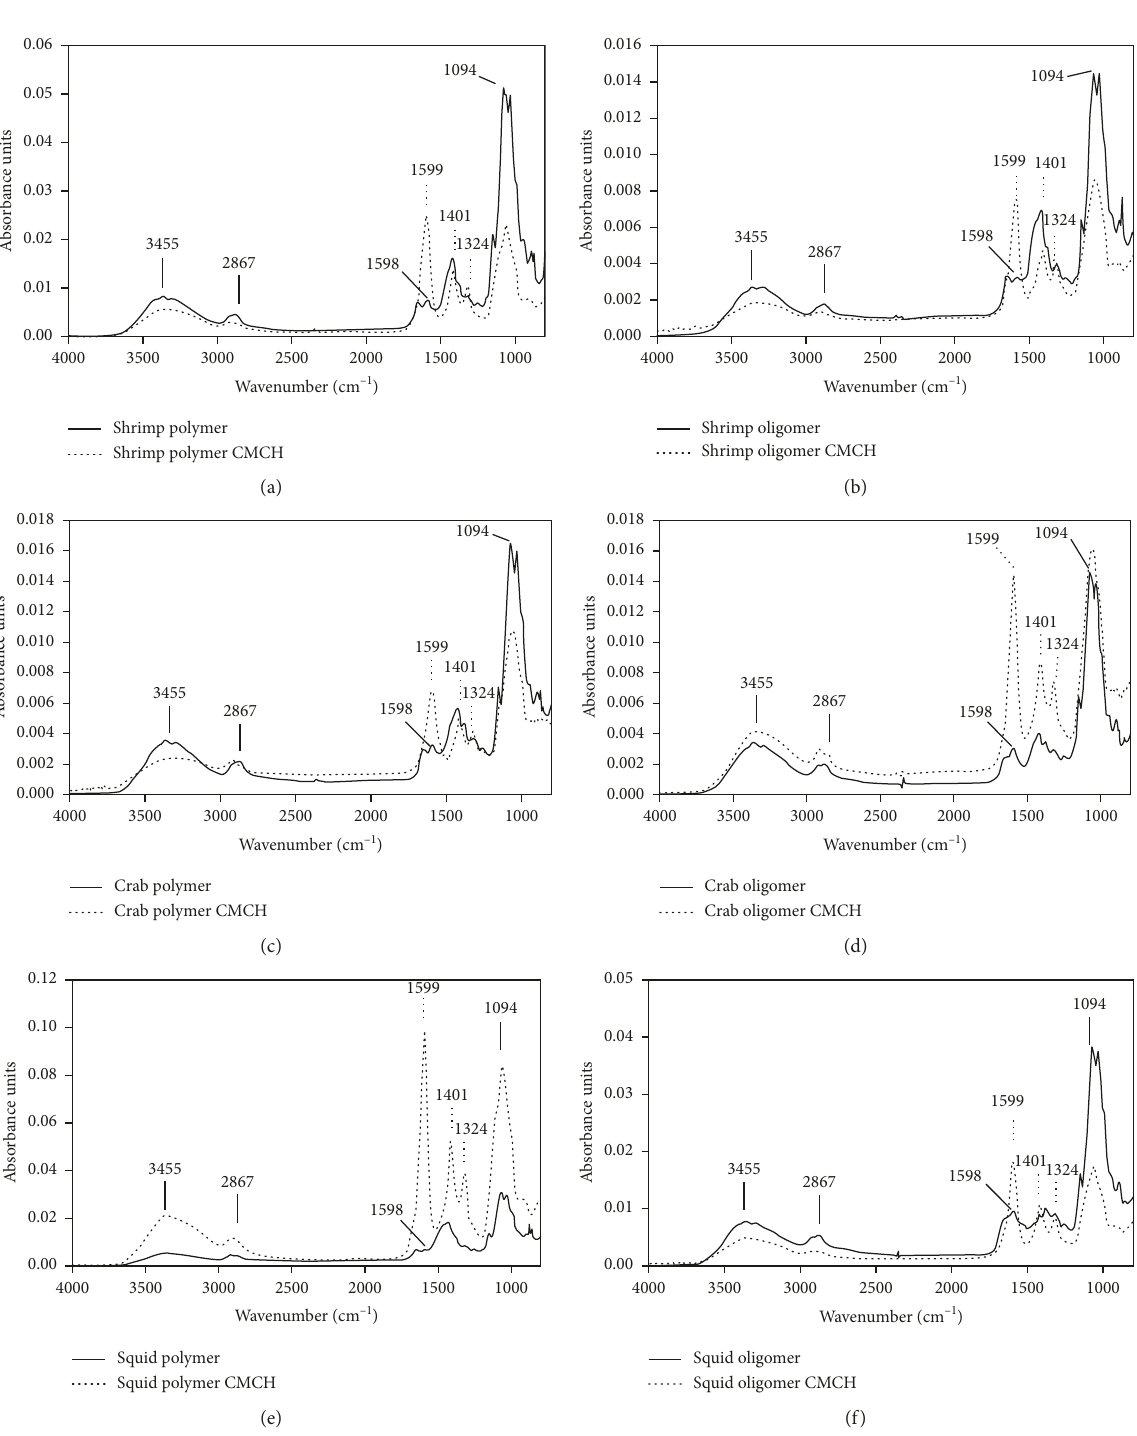
Figure 1: The FTIR spectra of native chitosan and CMCH: shrimp polymer and shrimp polymer CMCH (a); shrimp oligomer and shrimp oligomer CMCH (b); crab polymer and crab polymer CMCH (c); crab oligomer and crab oligomer CMCH (d); squid polymer and squid polymer CMCH (e); squid oligomer and squid oligomer CMCH squid oligomer CMCH films was observed to occur when PEG 400 was used as the plasticizer. This was somewhat expected because color change is attributed to the com- patibility limit of the polymer, thus causing phase separation (yellowness) values were found to range from 6.62 to and physical exclusion of the plasticizer [27]. 39.43. However, increased yellowness (high + b ) of the ∗ ∗